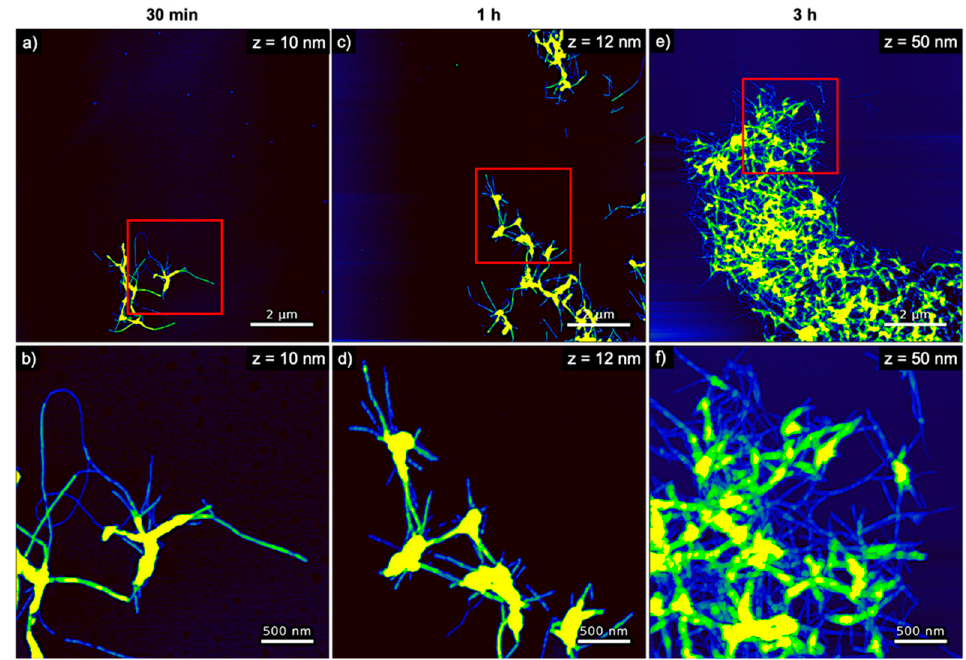
Figure 3. AFM images of pure hIAPP incubated without any DNA for ( a , b ) 30 min, ( c , d ) 1 h, and ( e , f ) 3 h. The images in ( b , d , f ) represent zooms of the regions indicated in the respective images in ( a , c , e ). The ranges of the z-scales are given in the individual images.